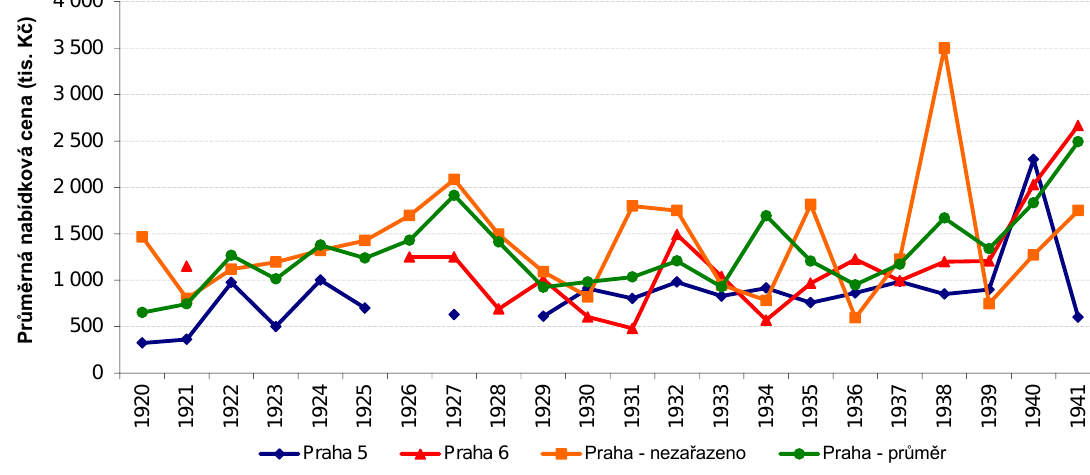
Obrázek 14: Průměrná cena bytového domu v Praze 5, 6, nezařazeno a průměr za Prahu jako